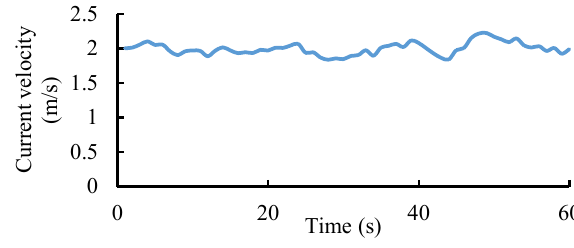
Figure 8. Turbulence sample at 2 m / s. Table 2. Cycles counted in a turbulence sample at 2 m/s.